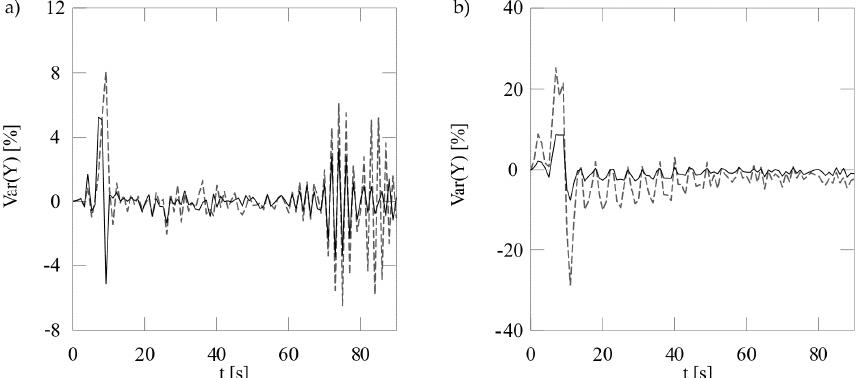
Figure 29. Percentage of variation of X coordinate of load’s center of mass for wind power having impact according to the direction of the: ( a ) X axis and ( b ) Y axis (continuous line—V w = 10 m/s, dotted line—V w = 20 m/s).